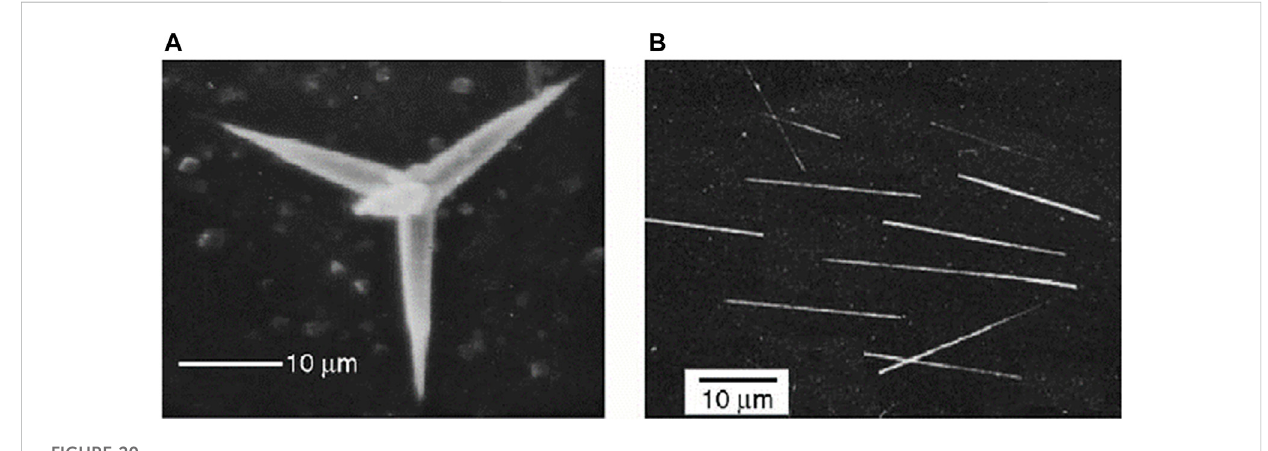
FIGURE 20 (A) SEM images of T-ZnO and (B) 1D ZnO whiskers (Zhou et al.,